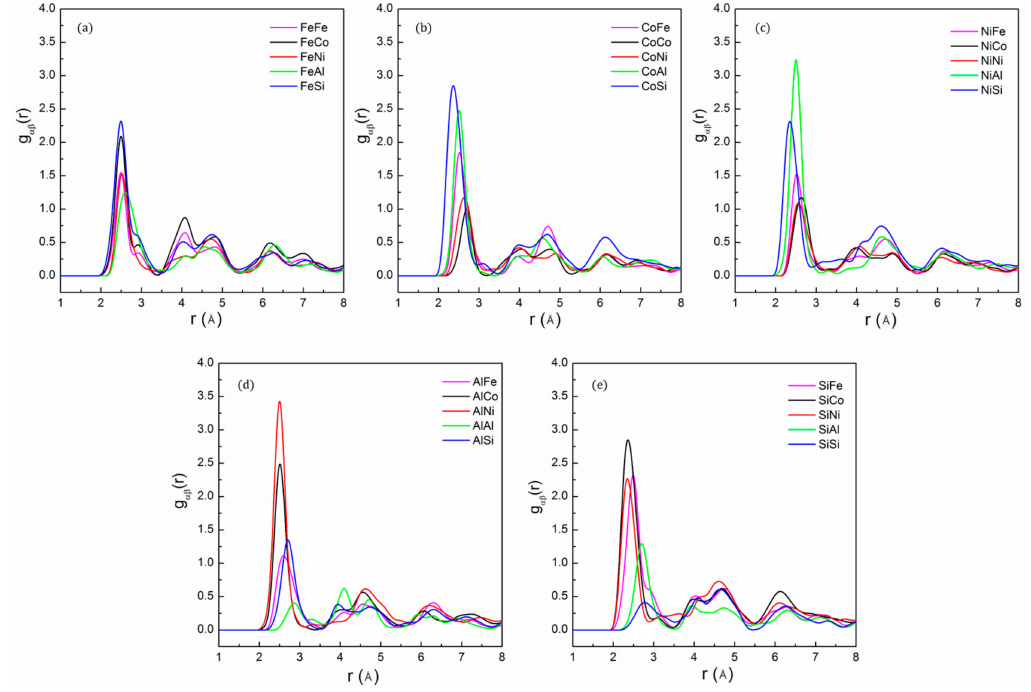
Figure 4. The partial pair distribution function: ( a ) Fe; ( b ) Co; ( c ) Ni; ( d ) Al and ( e ) Si of FeCoNi(AlSi) 0.8 alloy after the 3000 MC step, indicating short-range order between Ni-Al, Co-Si, Co-Al and Fe-Si